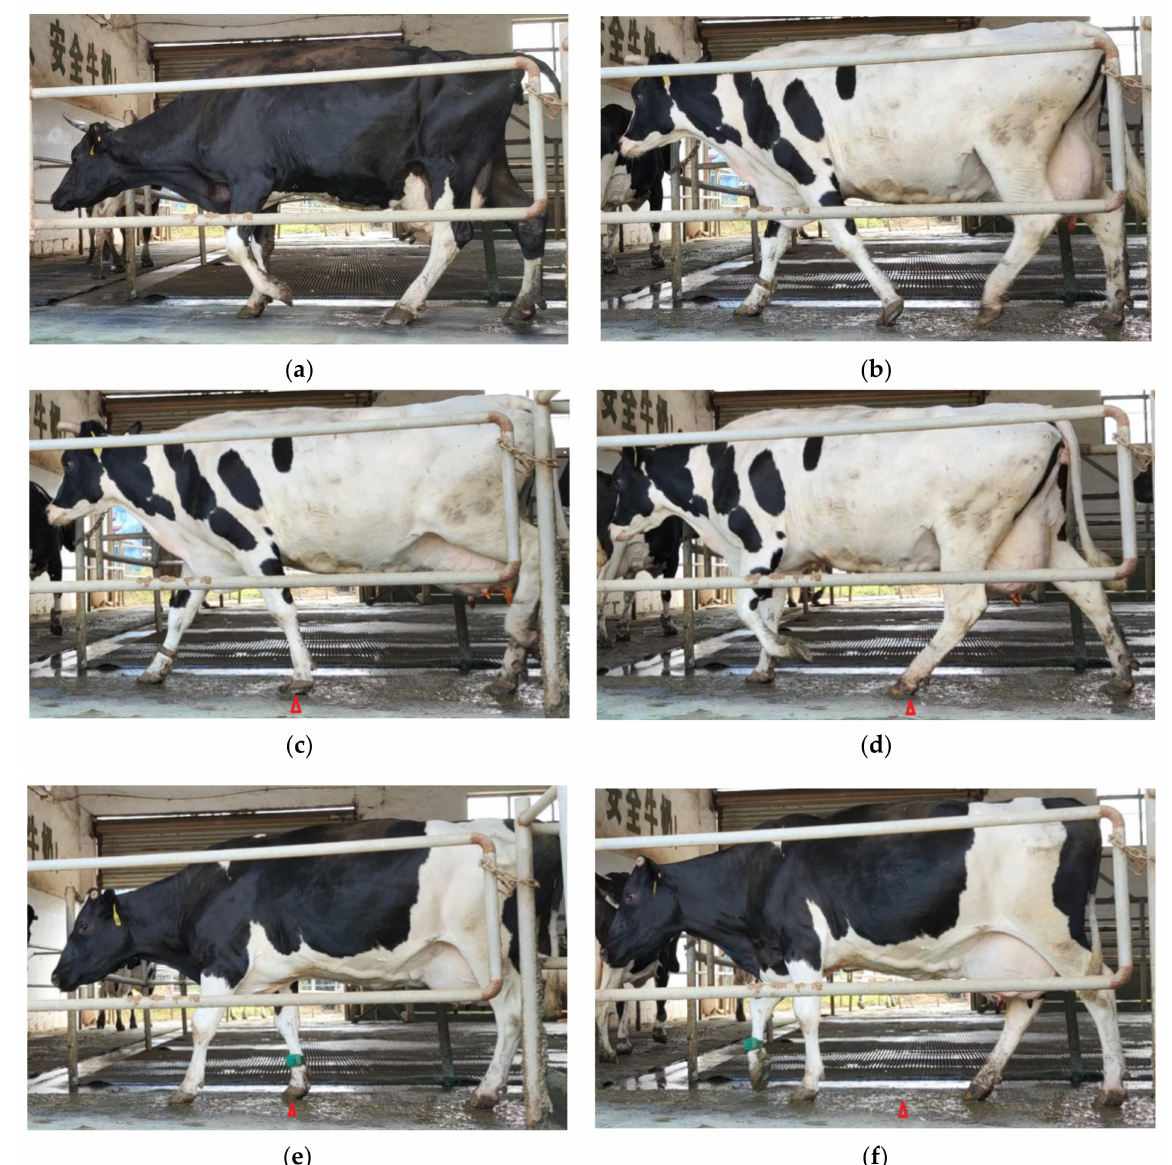
Figure 3. Examples of cows with various characteristics: ( a ) a cow with a back arch, ( b ) a cow without a back arch, ( c , d ) the hind hoof reached the front hoof position and ( e , f ) the hind hoof did not reach the front hoof position ( ∆ represents the front foot landing position). where X FL denotes the step position of the left front hoof,X HL denotes the step position of the left hind hoof, X FR denotes the step position of the right front hoof,X HR denotes the step position of the right hind hoof, ∆ Left denotes the trackway overlap of the left body side and ∆ Right denotes the trackway overlap of the right body